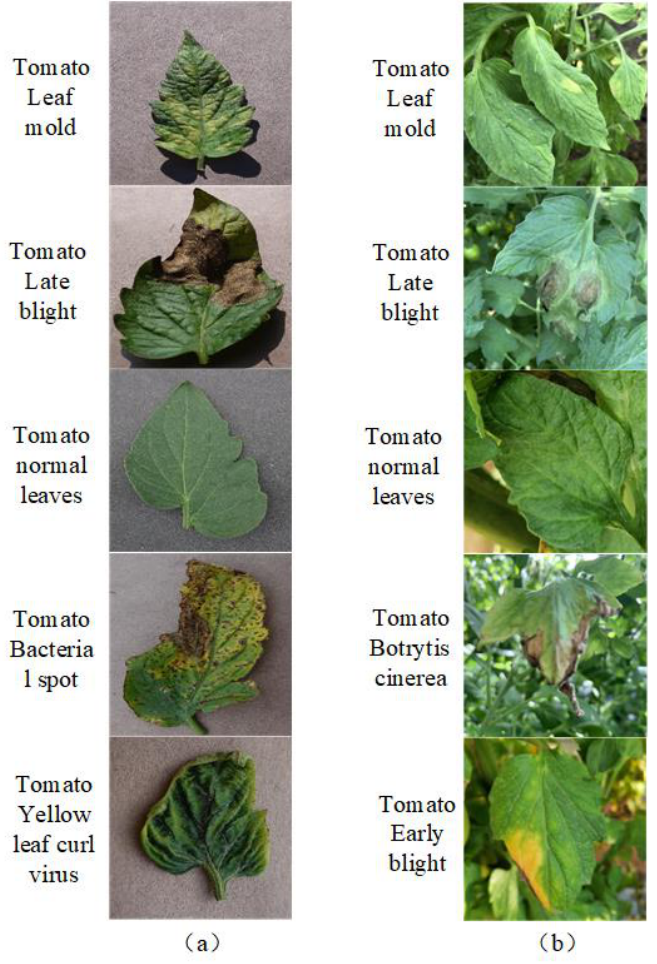
Table 1. The relationship between disease, temperature and humidity.